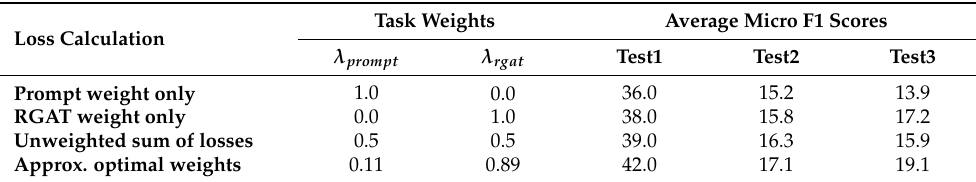
Table 7. Experiments of quantitative improvement with the multi-task loss. Results are shown from the three test